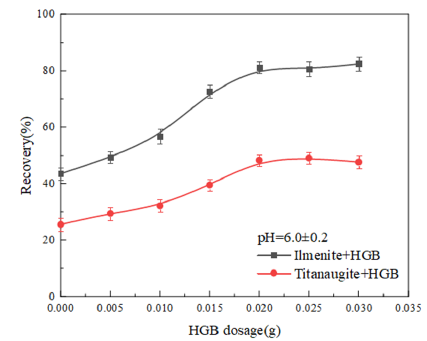
Figure 4. Effect of pH on flotation recovery of ilmentie and titanaugite treated with sodium oleate (the mineral size distributions of 38–74 µm, 2.0 × 10 −4 mol·L –1 sodium oleate).